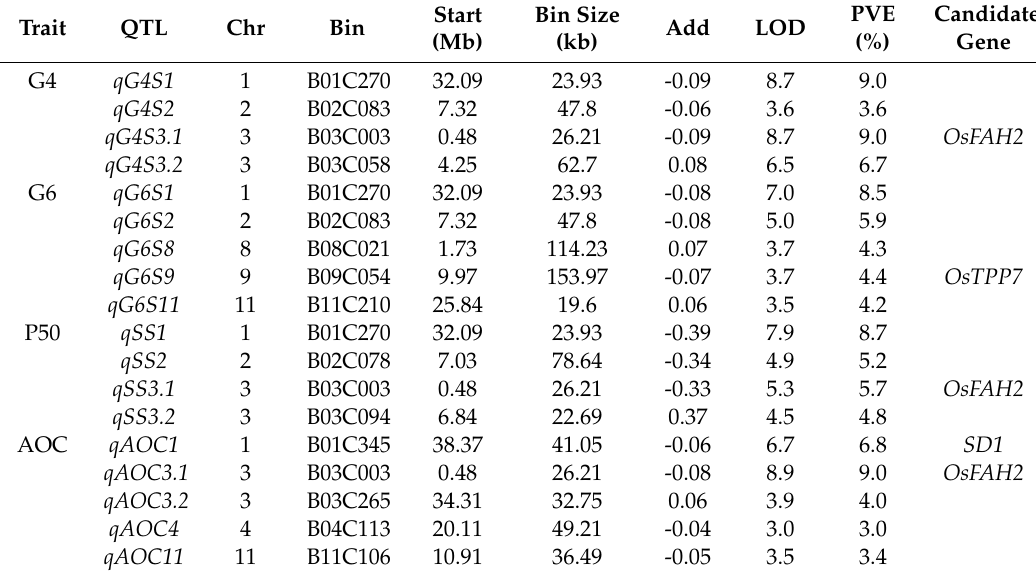
Table 1. Quantitative trait loci (QTLs) identified for seed storability and antioxidant capability in the 9311 / Nipponbare (NIP) backcross recombinant inbred lines